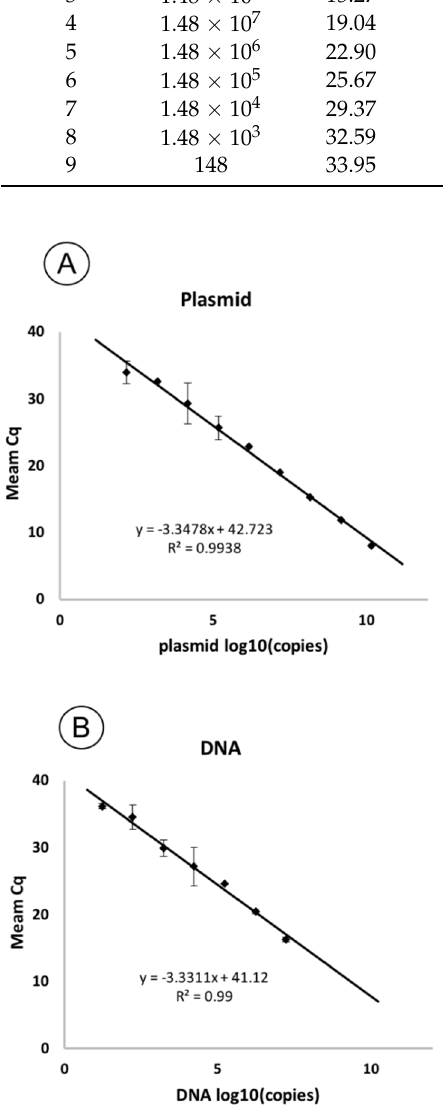
Figure 4. Standard curves showing the dependence of Cq on the concentration of pathogen DNA in the reaction. The curves are plotted based on the threshold cycles obtained for a series of ten-fold dilutions of the plasmid ( A ) and genomic DNA of the F149 strain ( B ). The standard deviation is shown as error bars.